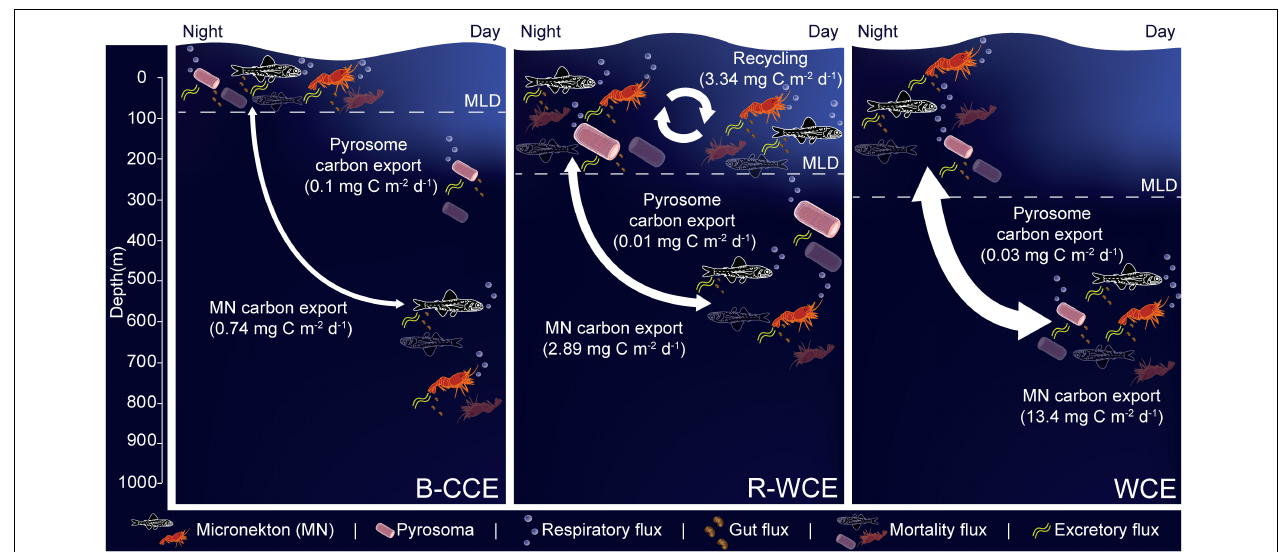
FIGURE 6 | Micronekton active carbon flux and depth of vertical migration in the B-CCE, R-WCE, and WCE. Dashed line represents the mixed layer depth (MLD). Estimates of pyrosome ( Pyrosoma atlanticum ) active carbon for the R-WCE and WCE were calculated in Henschke et al. (2019). Values reported assume 50% net efficiency ( Table 4 ). MF, mortality flux; GF, gut flux; RF, respiratory flux; and EF, excretory